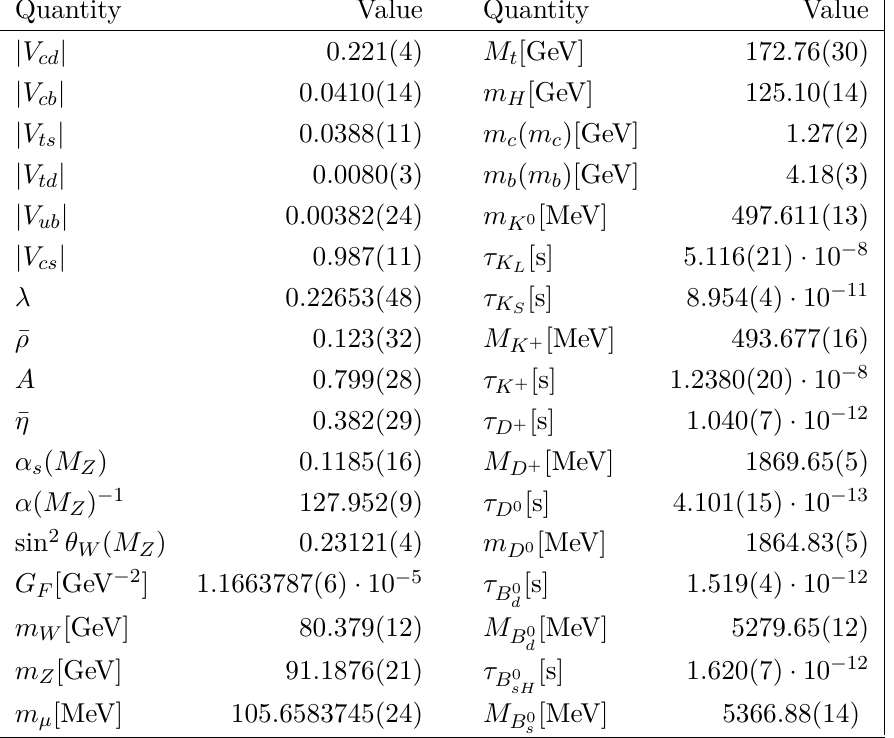
Table 4 . The central values are employed in the computations. All values are taken from Particle Data Group (PDG)